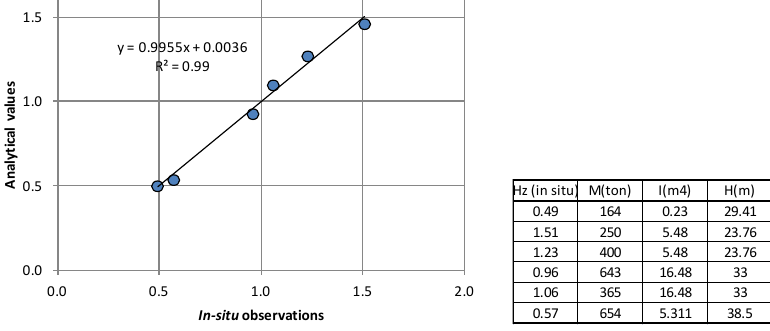
Fig. 8. 1st Mode − analytical frequencies vs. in-situ